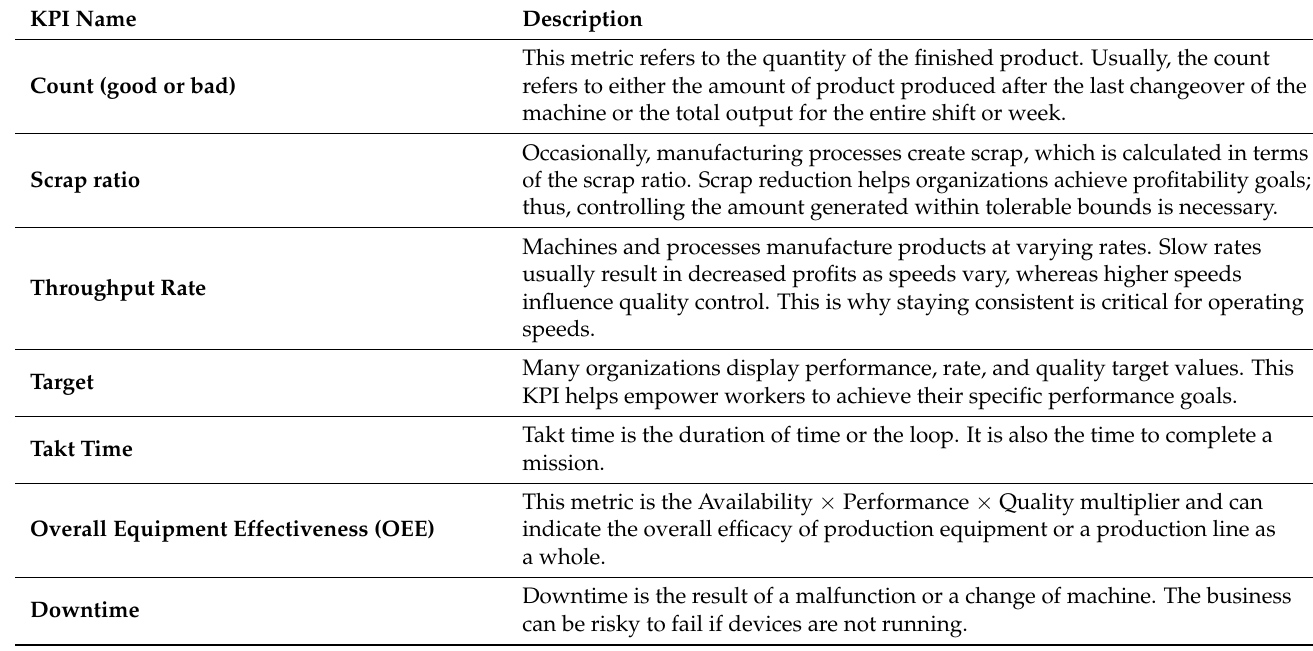
Table 4. Visual Process